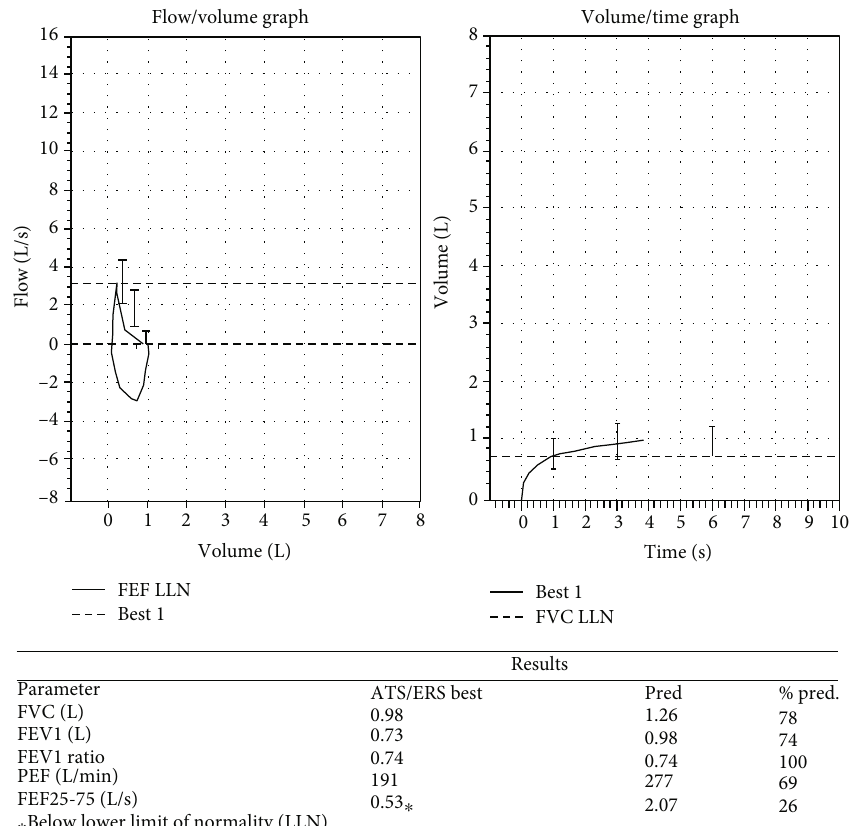
Figure 1: Spirogram before initiation of